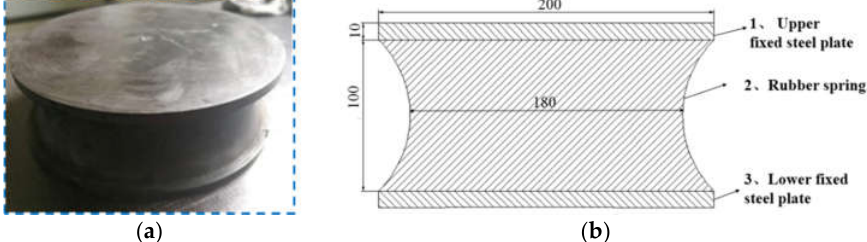
Figure 6. Shape and structure dimension of the measured component. ( a ) Outline. ( b ) Two- dimensional section view. section view.